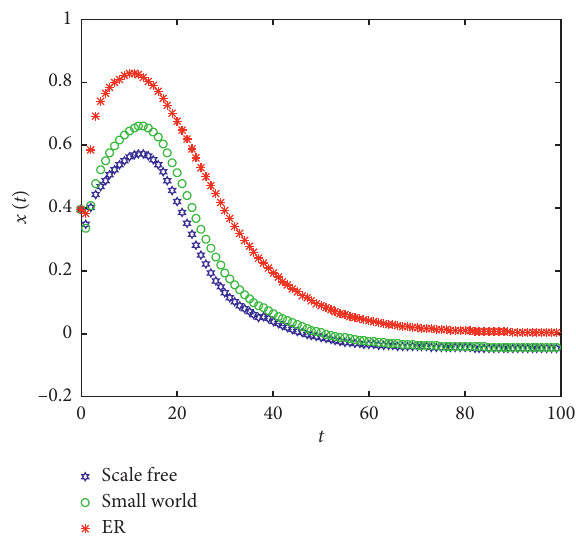
Figure 11: Impact of network topology on evolution of average collective